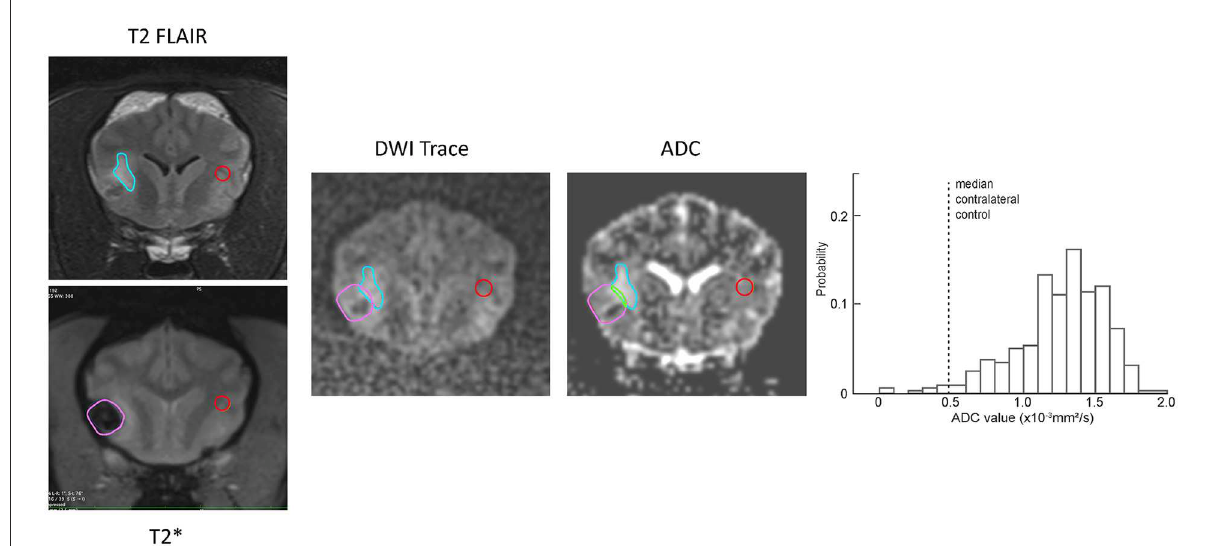
FIGURE5 Examples of ROI (blue outline) and contralateral normal control (red outline) region selection for a representative example hemorrhagic CVA. The regions were selected on the T2-FLAIR transverse images and copied to the DWI and ADC series. The region of T2* hypointensity was defined on the corresponding T2* transverse image (lavender outline). Pixels that were within both the T2-FLAIR hyperintense region and the T2* hypointense region (green outline) were excluded from the resulting probability histogram (right). The histogram shows the ADC values of non-excluded pixels within the ROI, as well as the median ADC value within the contralateral control region (dotted